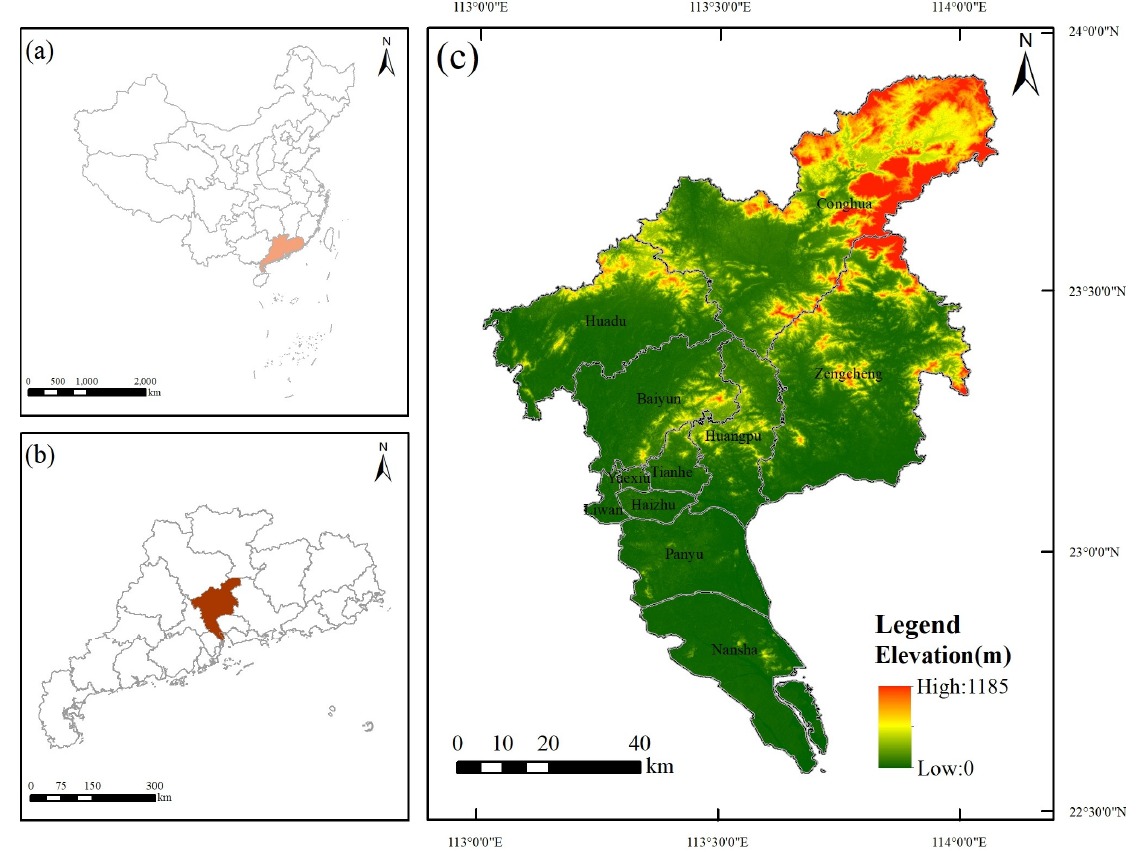
Figure 1. Location of the study area: ( a ) Guangdong’s location in China; ( b ) Guangzhou’s location in Guangdong; ( c ) Administrative and topographic map of Guangzhou.